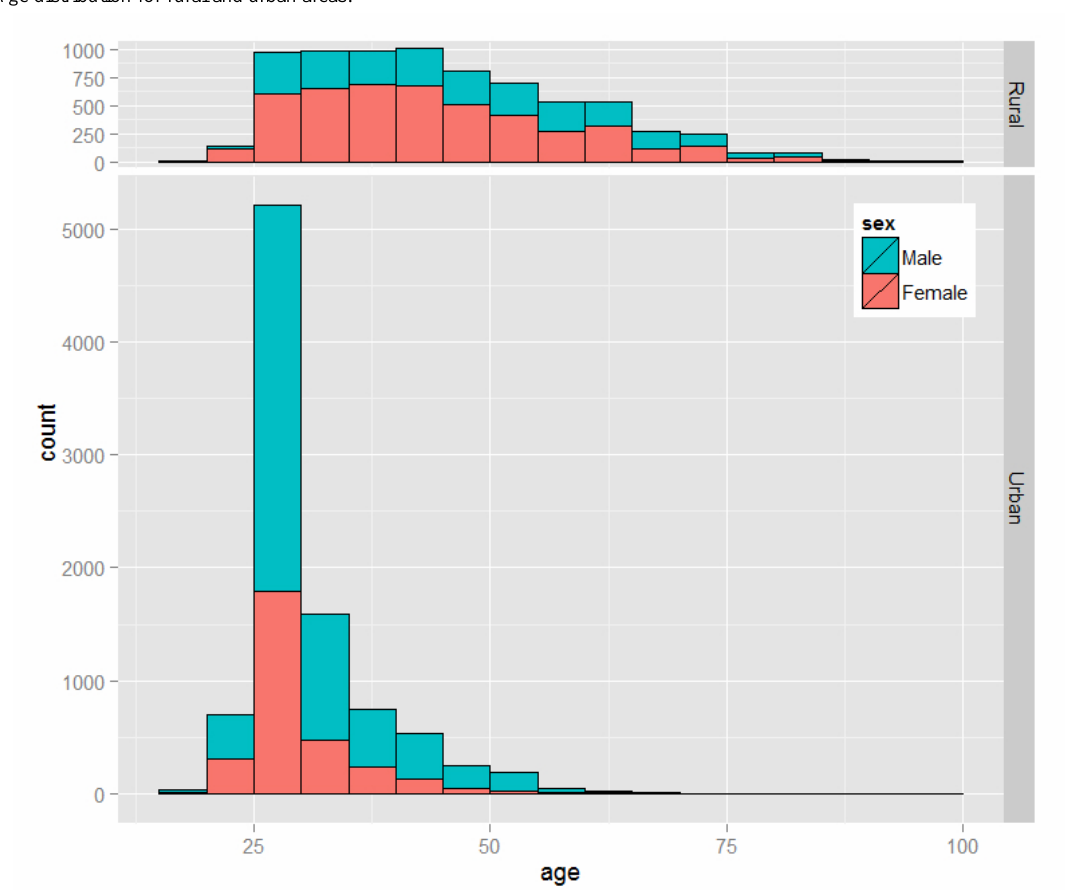
Figure 4. Age distribution for rural and urban